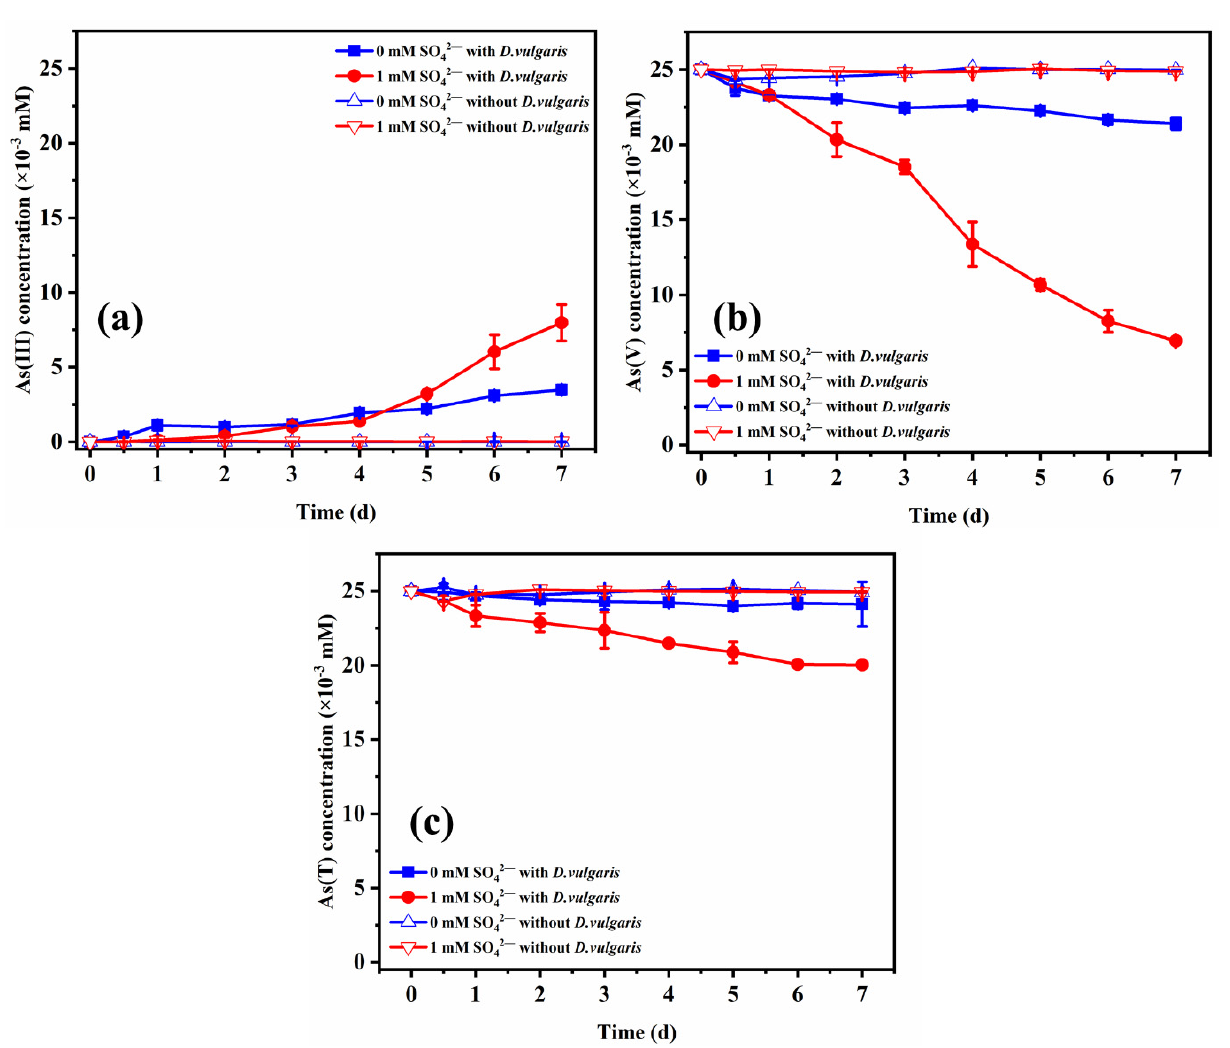
Figure 6. The changes of As(III) ( a ), As(V) ( b ), and As(T) ( c ) concentrations during As(V) reduction experiment. Error bars indicate standard deviation of triplicates.